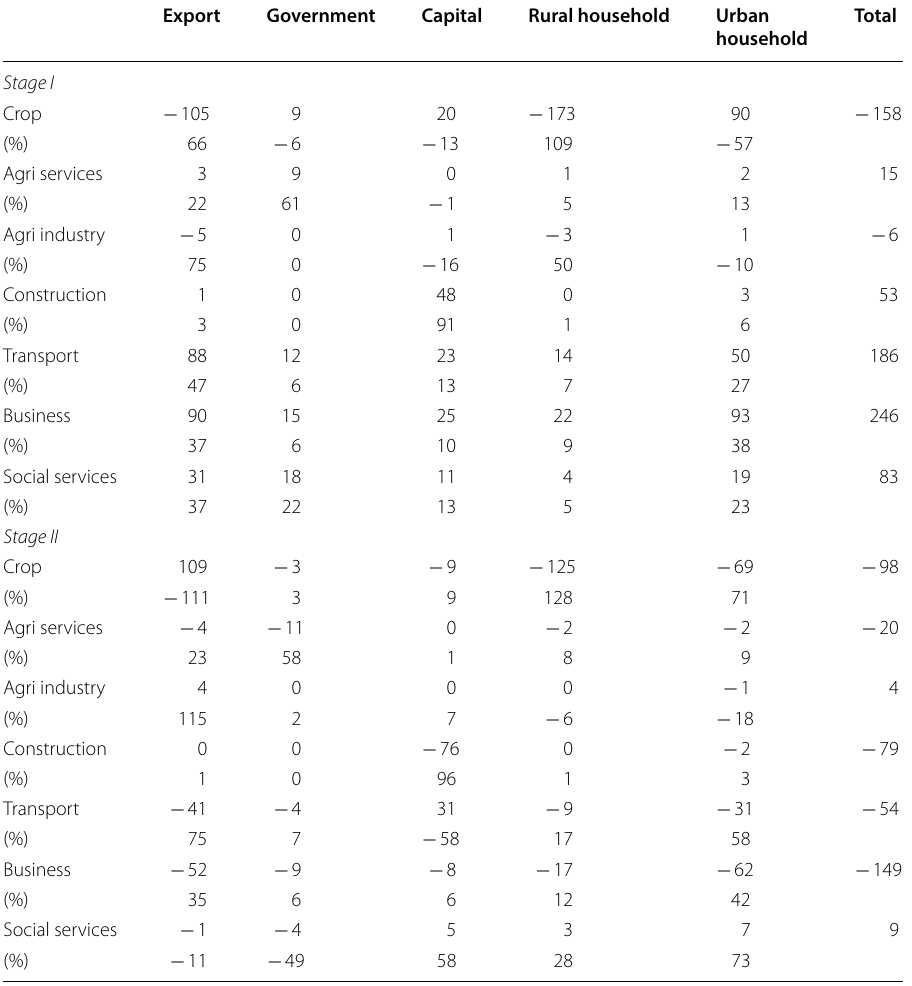
Table 4 Change of employment inducement from 2002 to